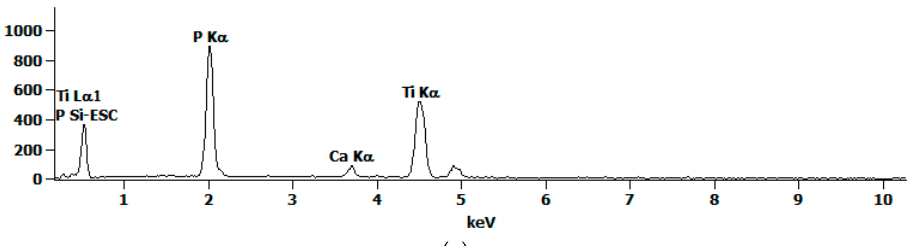
Figure 2. SEM pictures ( a – d ) and EDS spectrum ( e ) of the porous coating formed on CP Titanium Grade 2 after PEO treatment at voltage of 450 V in 300 g Ca(NO 3 ) 2 ·4H 2 O in 1000 mL H 3 PO 4 Magnifications: ( a ) 500 × , ( b ) 1000 × , ( c ) 5000 × , ( d ) 10,000 × .